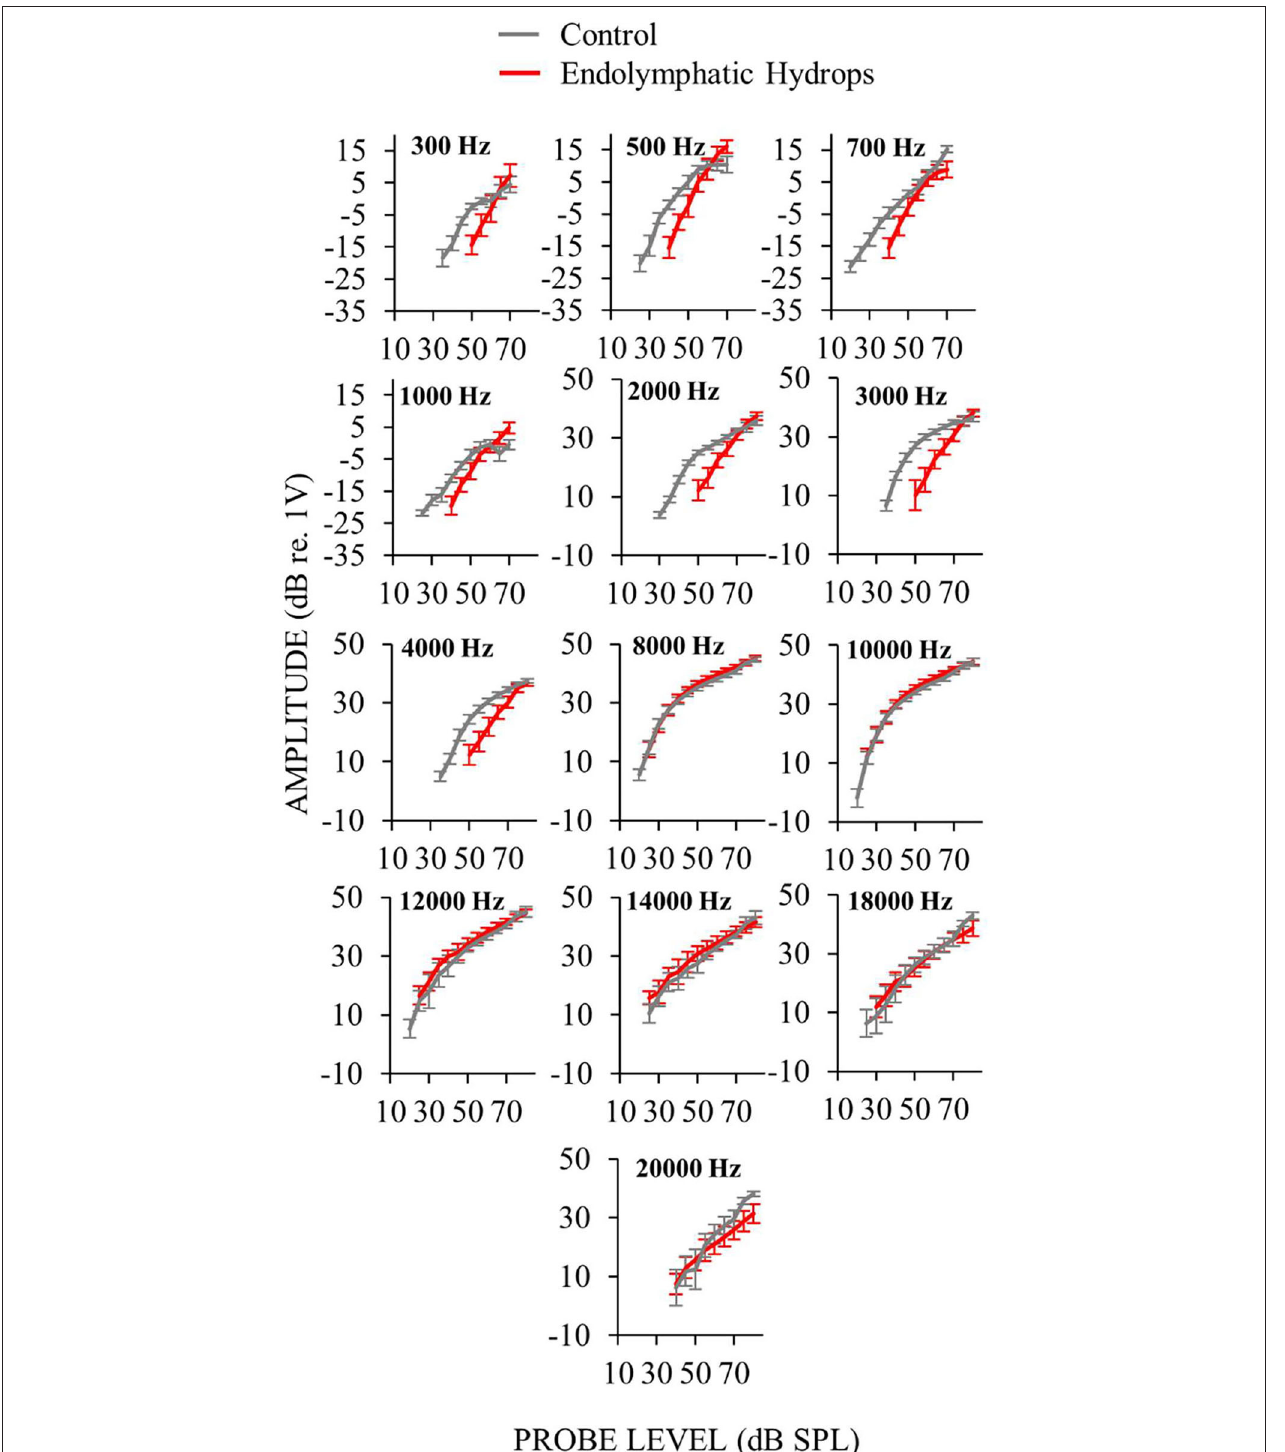
FIGURE 3 | Auditory-nerve response amplitudes from ears with endolymphatic sac ablation (red) and control ears (gray) as functions of sound level for many frequencies. Measurements at low-frequencies ( ≤ 1kHz) were made with ANOW and at mid- and high-frequencies (2–4 and ≥ 8kHz) were made with CAPs. Only measurements that were at, and above, threshold are plotted. Control animals were naïve or underwent a sham-surgery. Points are averages from 18 (low frequencies) or 15 (mid and high frequencies) ears with endolymphatic sac ablation, and eight control ears. Error bars are one standard error of the mean. Response recruitment was seen at low and mid frequencies in that thresholds were elevated but responses converged to near normal at high-levels.